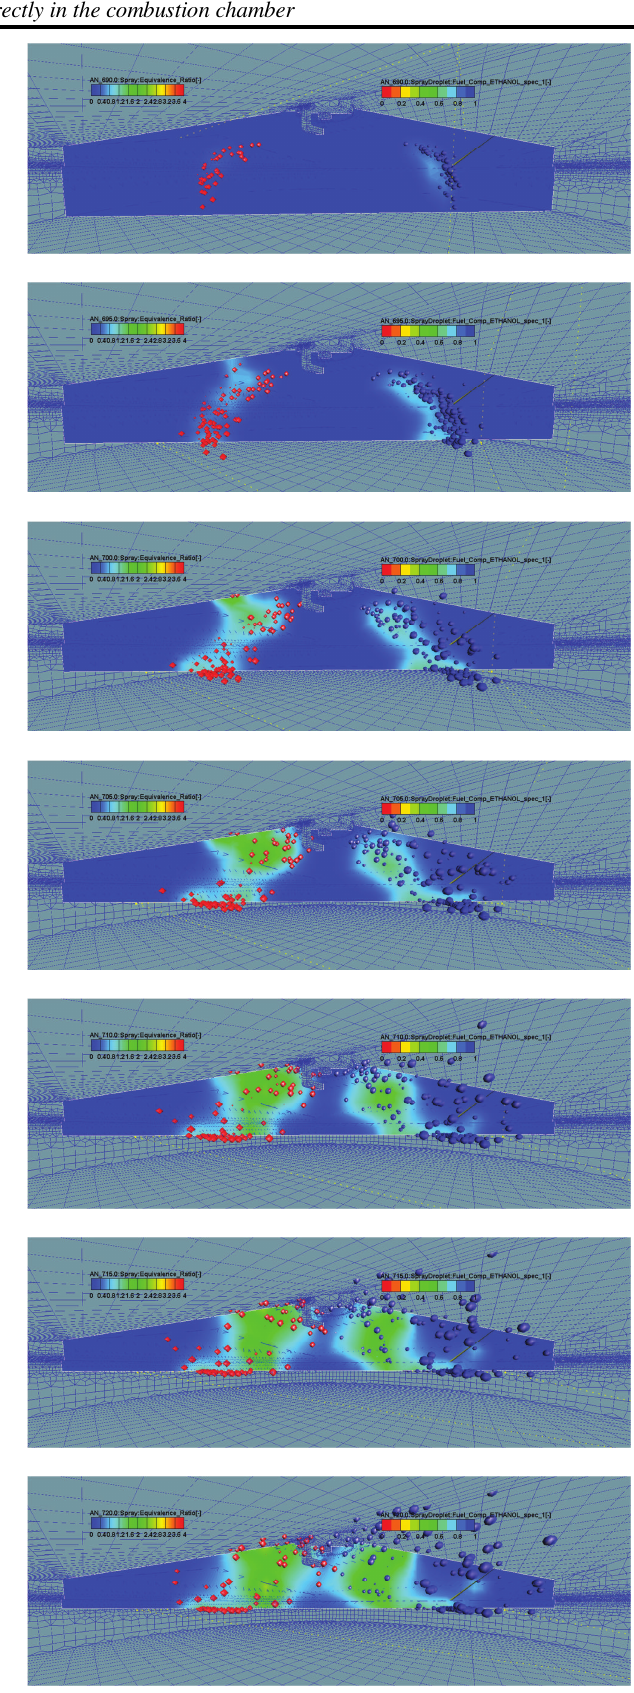
Fig. 10. The development of the gasoline (red spheres) and ethanol (blue spheres) streams in the two-injectors system (combustion chamber section concerns the 1/ l